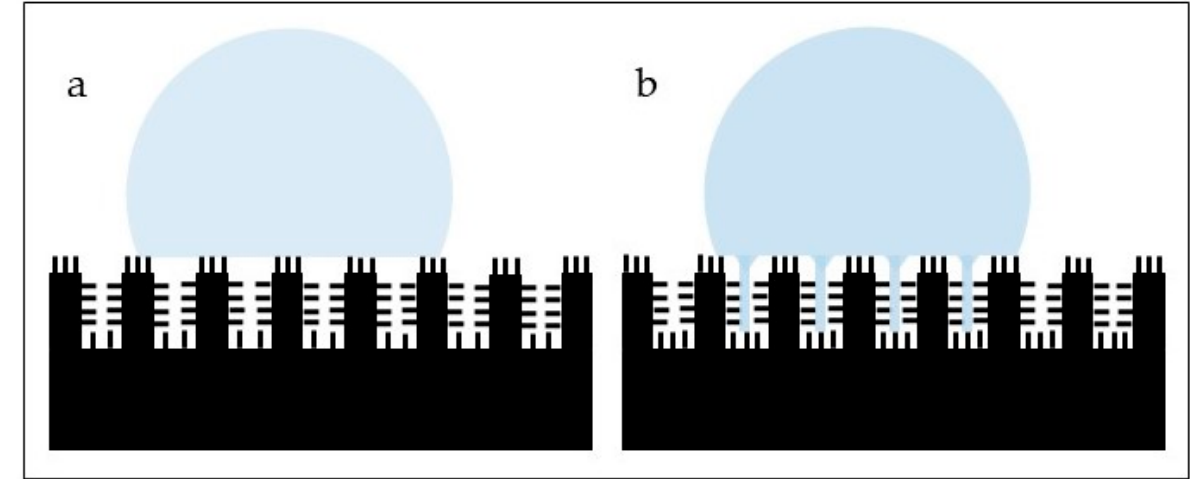
Figure 5. Lotus ( a ) and rose petal ( b ) effects. Table 2. Topographic features and biomedical applications of different vegetal surfaces.